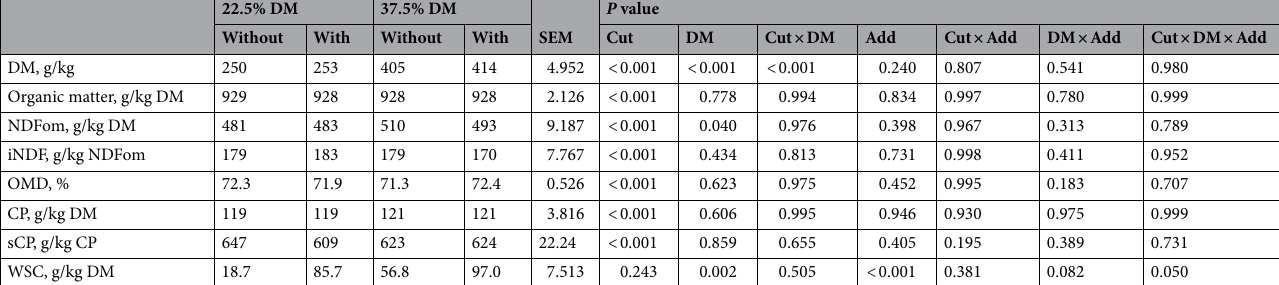
Table 4. Effect of wilting rate (target 22.5 or 37.5% DM) and silage additive (without or with) on silage feed quality parameters averaged across cuts and crop types (n = 15). DM, dry matter; NDFom, neutral detergent fibre; iNDF, indigestible NDF; OMD, organic matter digestibility; CP, crude protein; sCP, soluble crude protein; WSC, water-soluble carbohydrates. Cuts are numbered 1, 3 and 5 for the three consecutive cuts in the three-cut system and 2 and 4 for 1st and 2nd cut in the two-cut system, respectively. Cut × DM: Interaction between cut and dry matter; Add, Silage additive (with or without); Cut × Add: Interaction between cut and Add; DM × Add, interaction between DM and Add; Cut × DM × Add, three-way interaction between Cut, DM and Add.